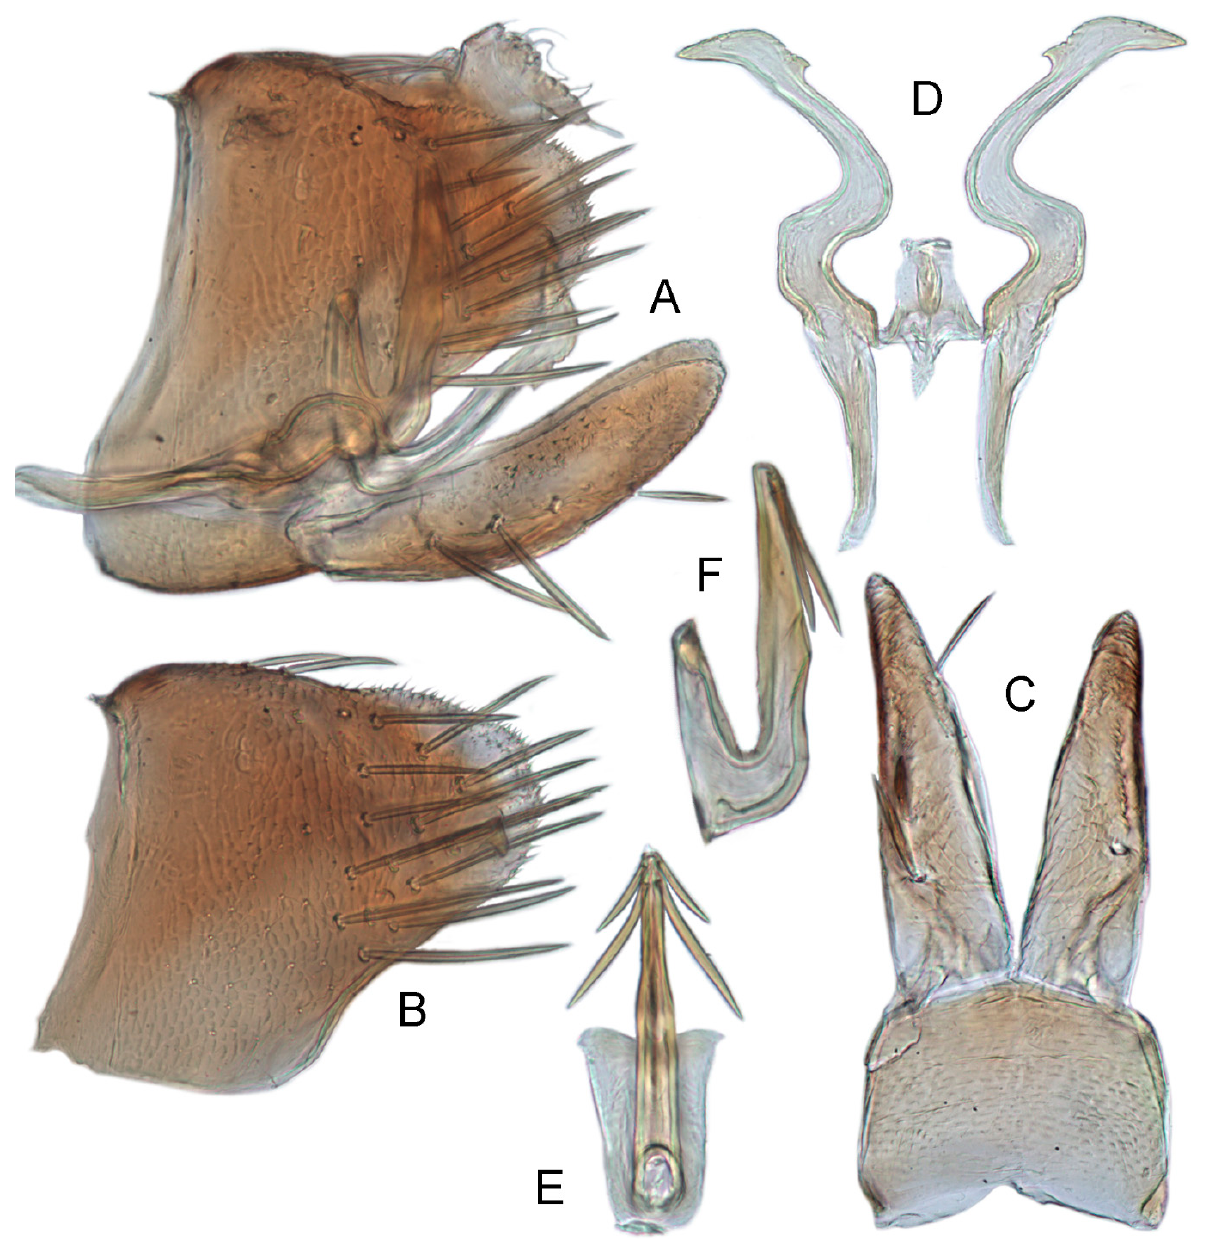
Figure 11. Xestocephalus toroensis Matsumura, 1914, n. rec. ( A ) Male genital capsule, lateral view; ( B ) pygofer lobe, lateral view; ( C ) subgenital plates and valve, ventral view; ( D ) style and connective, ventral view; ( E ) aedeagus, posterior view; ( F ) aedeagus, lateral view.